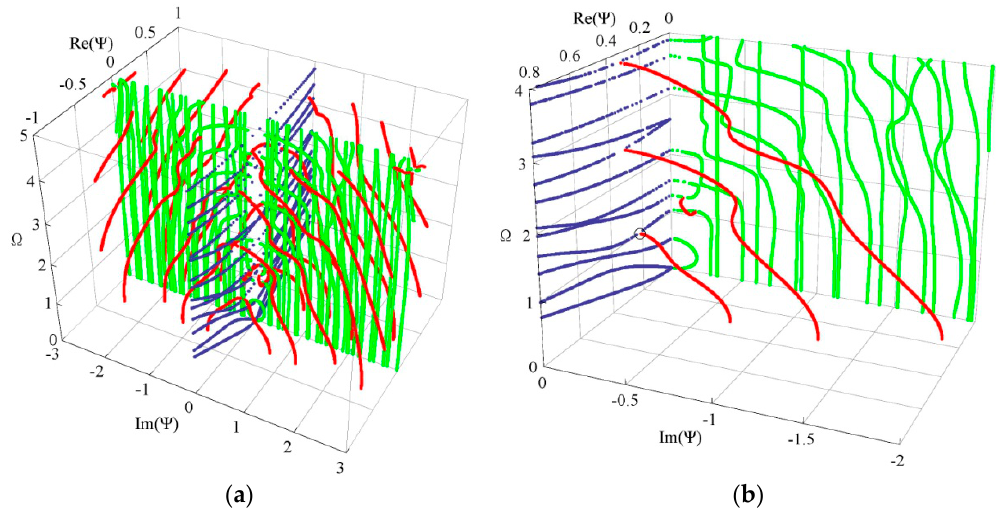
Figure 5. 3D dispersion curves of Lamb wave: ( a ) four quadrants, ( b ) one quadrant; blue—real solutions, green—imaginary solutions, red—complex solutions.